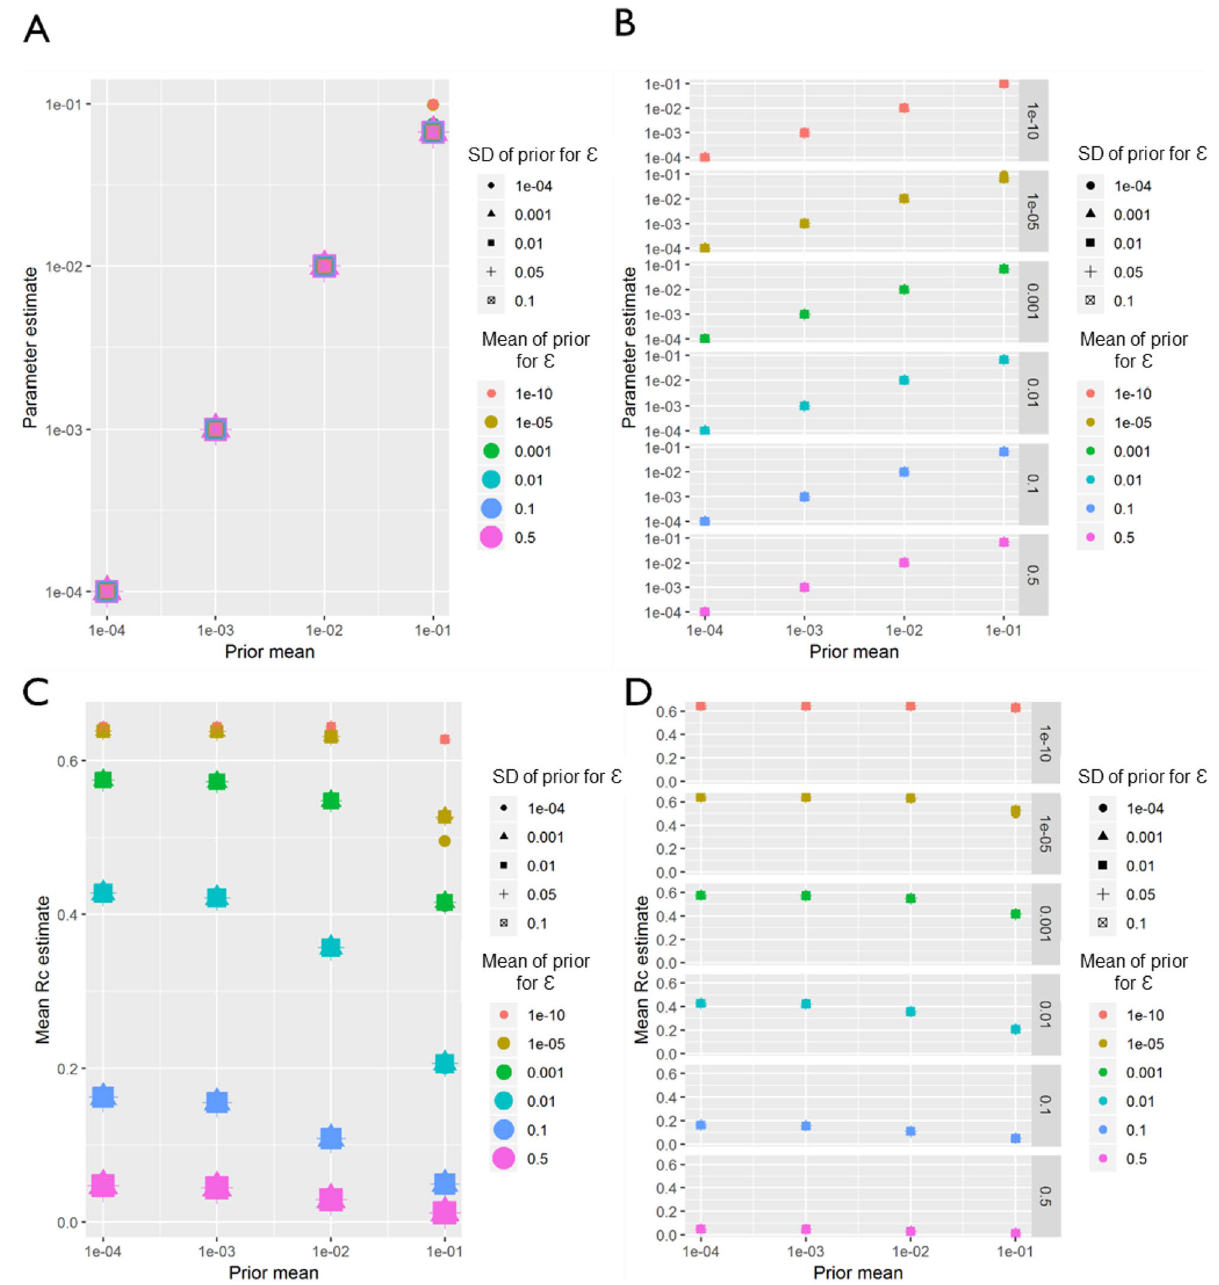
Figure 9. El Salvador sensitivity analysis. Sensitivity analysis showing the impact of varying the prior mean for the distance kernel shaping parameter, β. The different colours and shapes represent different means and standard deviations respectively of the normally-distributed prior of epsilon, ε, which represents shapes represent different hazards of infection by an external, unobserved source. For A-D, the x-axis represents the prior mean used for β. ( A ) the y-axis shows the maximum a posteriori parameter estimate for the parameter β. ( B ) shows the same results, stratified by the prior mean of ε for clarity. ( C ) Shows the impact of priors for β and ε on the mean Rc estimate, and again ( D ) shows the same result, stratified by the prior mean of